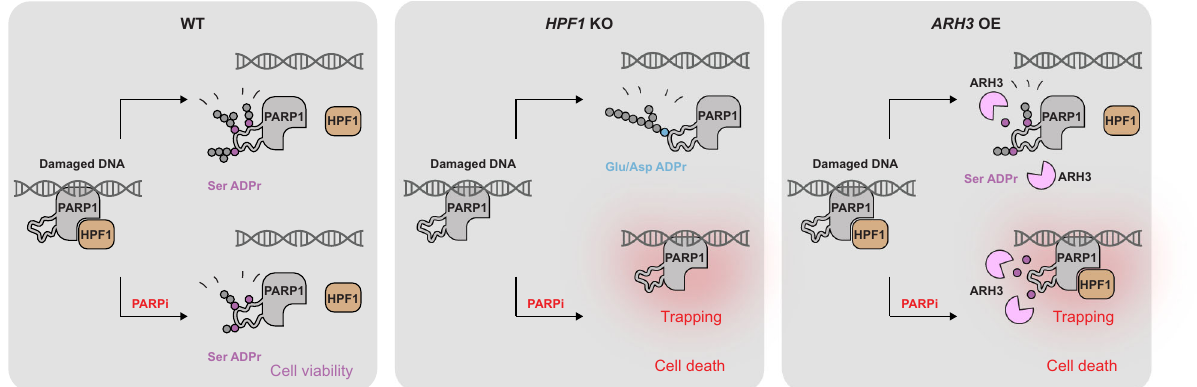
Fig. 4 Proposed model of the effect of HPF1 de fi ciency and ARH3 overexpression on PARP1/PARP2 inhibitor response. In WT cells, HPF1 allows ef fi cient PARP1 auto-modi fi cation at serine residues, especially 499, 507 and 519. This modi fi cation is more ef fi ciently produced and therefore partially persists at higher inhibitor concentrations compared to HPF1-independent auto-modi fi cation (presumably primarily at glutamate or aspartate residues). In the presence of PARP1/PARP2 inhibitors (PARPi), HPF1-dependent serine auto-modi fi cation partially escapes inhibition and promotes cell viability by counteracting PARP1 trapping. This mechanism is compromised in HPF1 KO cells (due to the loss of ef fi cient serine ADPr synthesis) and ARH3 OE (due to higher levels of serine ADPr hydrolysis), leading to PARP1 trapping and cell death upon inhibitor treatment. Endogenous levels of ARH3 in WT and HPF1 KO cells are not